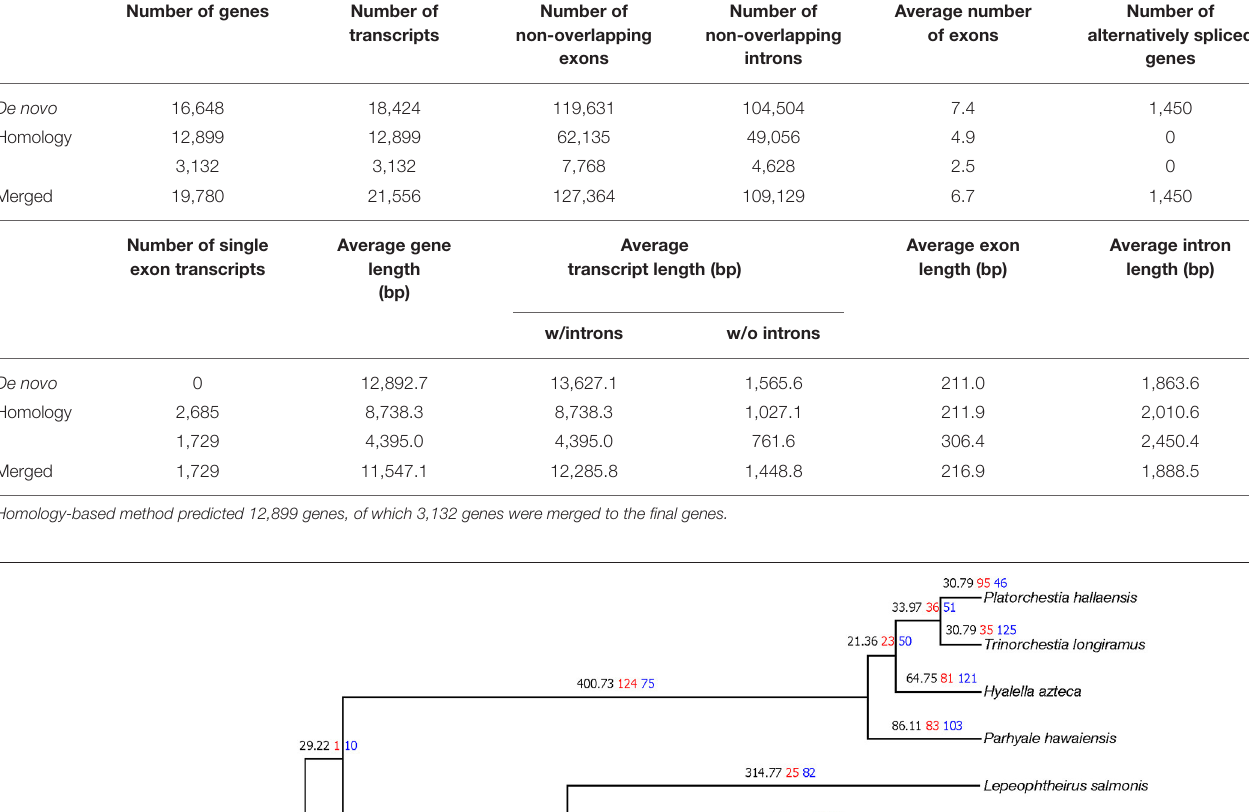
TABLE 2 | Statistics of predicted protein-coding genes.